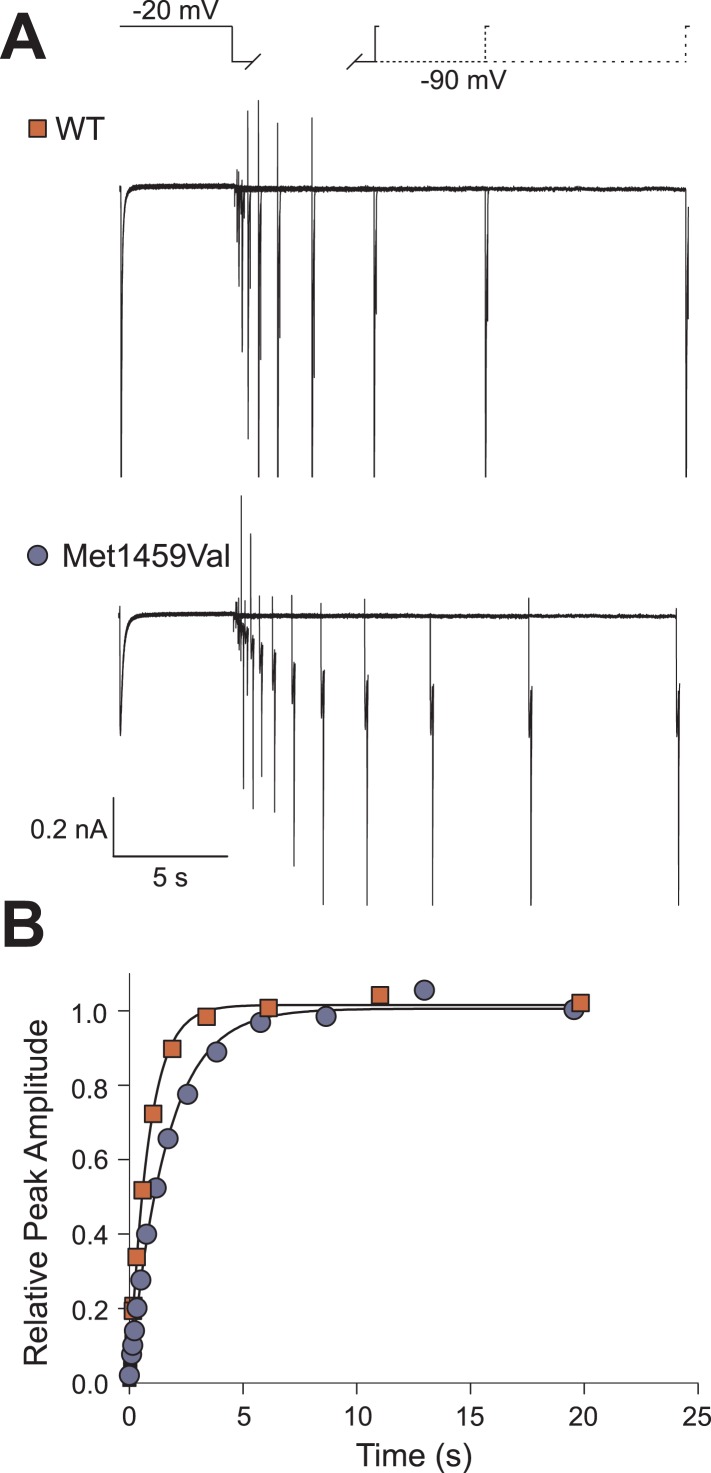
Recovery from inactivation is slightly slower in CACNA1HM1549V.(A) The recovery from inactivation at −90 mV is decelerated in CACNA1HM1549V. Representative current recordings of CACNA1HWT or CACNA1HM1549V channels. Channels were activated and subsequently inactivated by clamping the membrane potential to −20 mV for 5 s. Afterwards, cells were held at −90 mV for increasing durations followed by short activation at −20 mV. The peak amplitude at the last −20 mV step is dependent on the number of non-inactivated channels that increases upon longer intervals at −90 mV. (B) Monoexponential fits to the plot of the relative peak amplitudes vs the time spent at −90 mV reveal a slight delay in the recovery from inactivation of CACNA1HM1549V channels (time constants for CACNA1HWT: 871.4 ± 52.6 ms, n = 6; CACNA1HM1549V: 1689.0 ± 70.9 ms, n = 10; p = 1 × 10−6). Source files are available in Figure 5—source data 1.